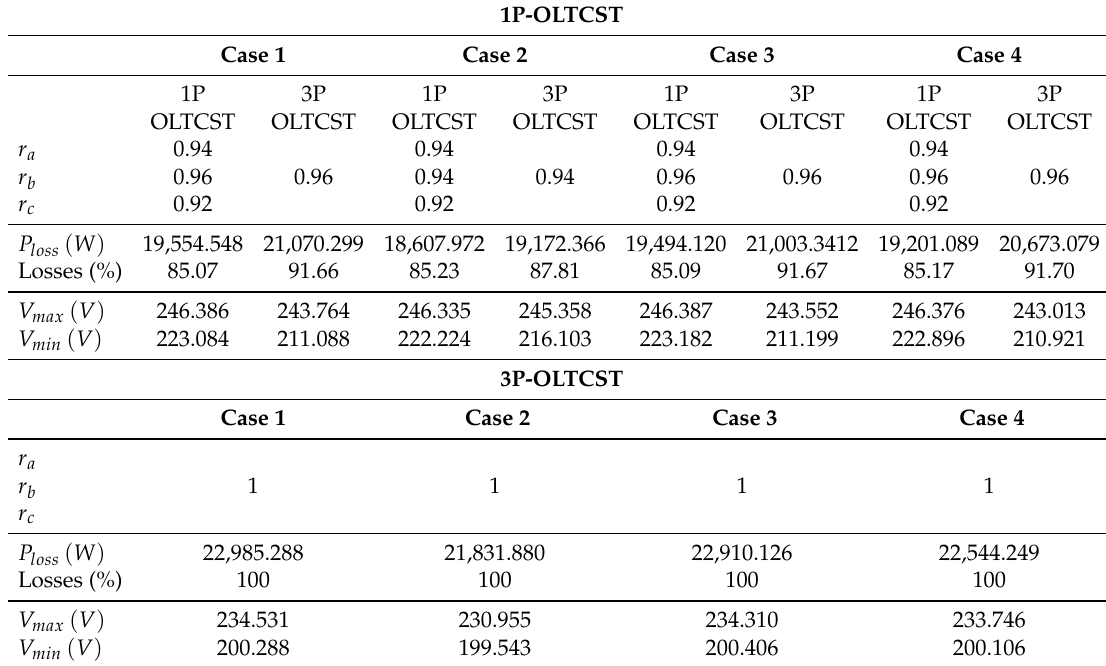
Table 6. Simulation results for different neutral ground